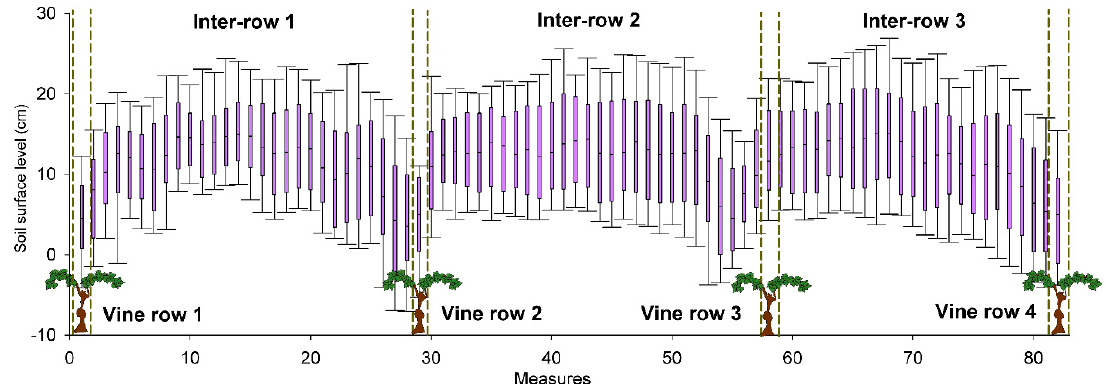
Figure 3. Box plots using the total measured points ( n = 5904). The black line in each box plot represents the median value. The 5th and 95th percentiles are also included.